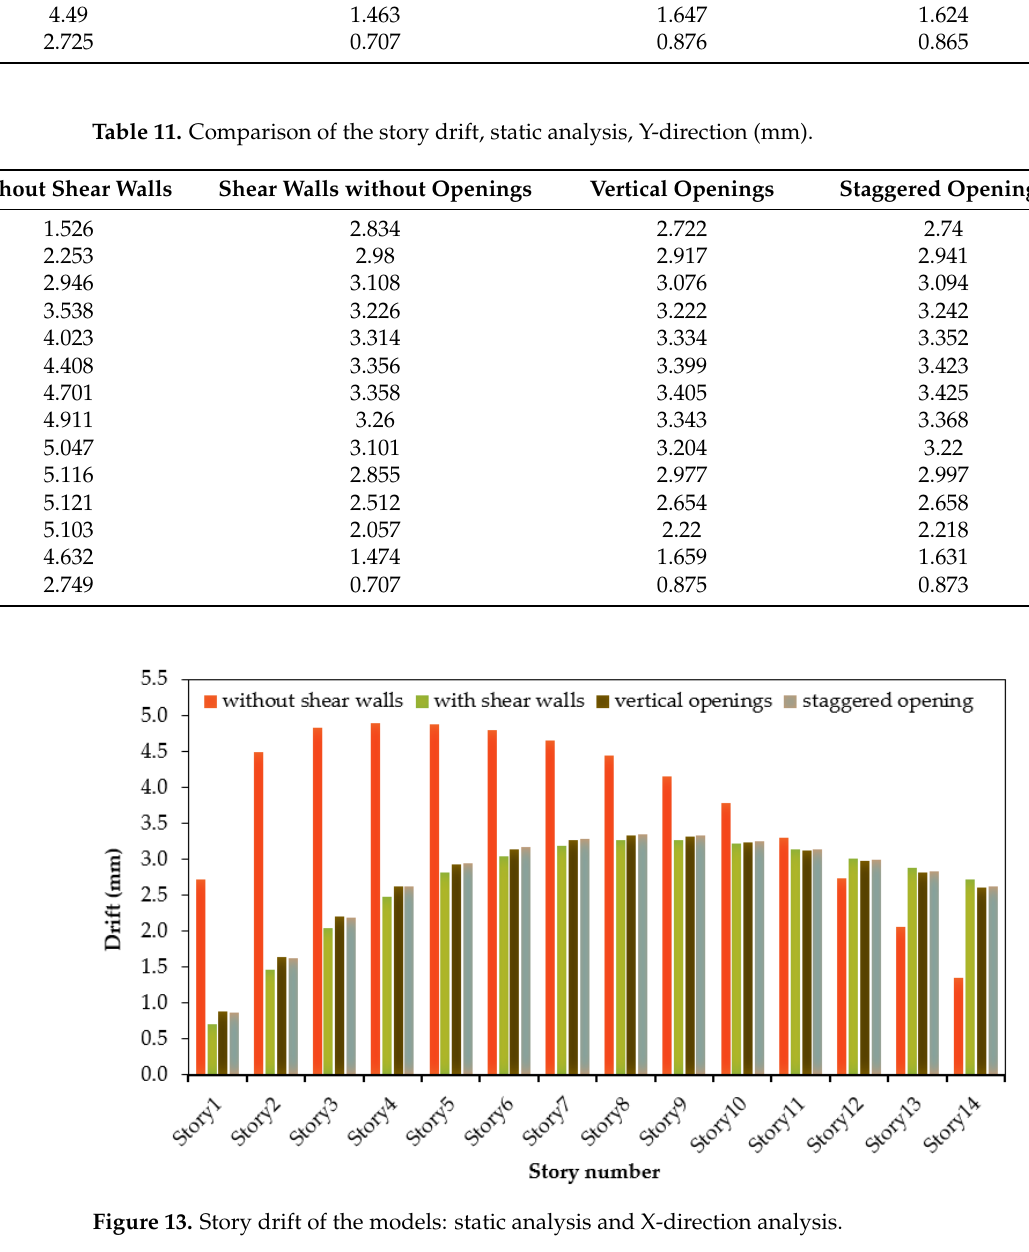
Figure 14. Story drift of the models: static analysis and Y-direction (mm). Tables 12 and 13 and Figures 15 and 16 demonstrate the story drifts in the case of response spectrum analysis (RSA) in the (X&Y) direction. The results show that the max- imum drift seen on the third floor due to the building without shear walls is 4.476 mm in X-direction and 4.6 mm in Y-direction. It is consequently observed that the maximum drift story of the building with shear walls seen on the eighth floor is 2.544 mm, 2.566 mm, and 2.585 mm for the building ’ s vertical and staggered opening, respectively, in X-direction. However, shear walls without openings have a 2.573 mm thickness, while shear walls with vertical and staggered openings in the Y-direction have 2.614 mm and 2.63 mm thick- nesses, respectively.